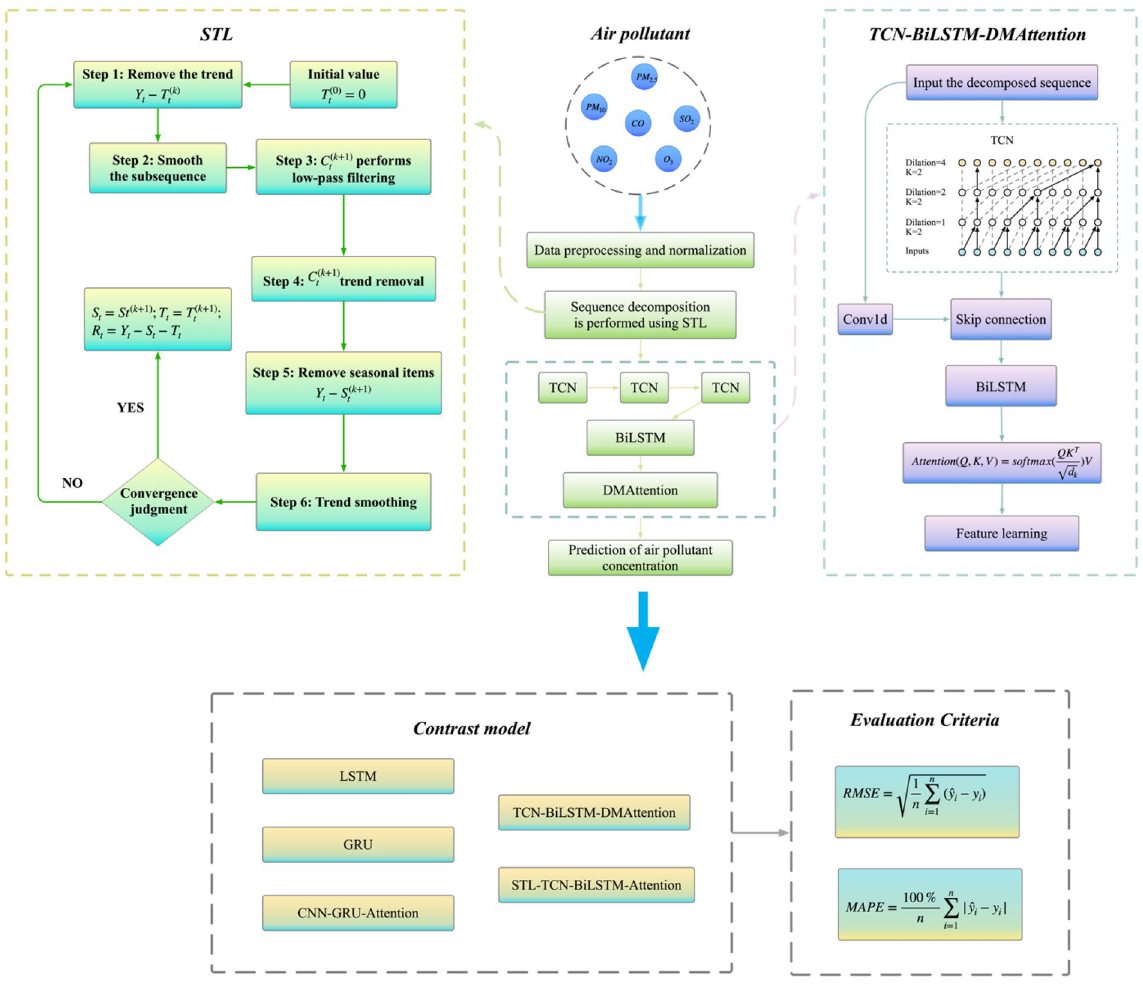
Figure 1. Flowchart of this